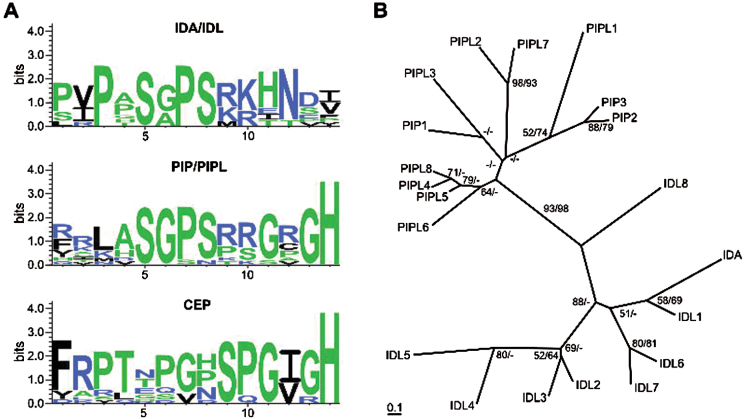
Phylogenetic relationship between the IDA/IDL and PIP/PIPL peptides. (A) Sequence logo representation of the conserved C-terminal of IDA/IDL, PIP/PIPL and CEP peptides. (B) N-J and ML trees were constructed based on the protein alignment of the IDA/IDL and PIP/PIPL families shown in Fig. 1A. The N-J trees are shown. The overall topologies for the N-J and ML trees are the same. Bootstrap confidence values above 50% for N-J (first value) and ML (second value) are shown in the tree.